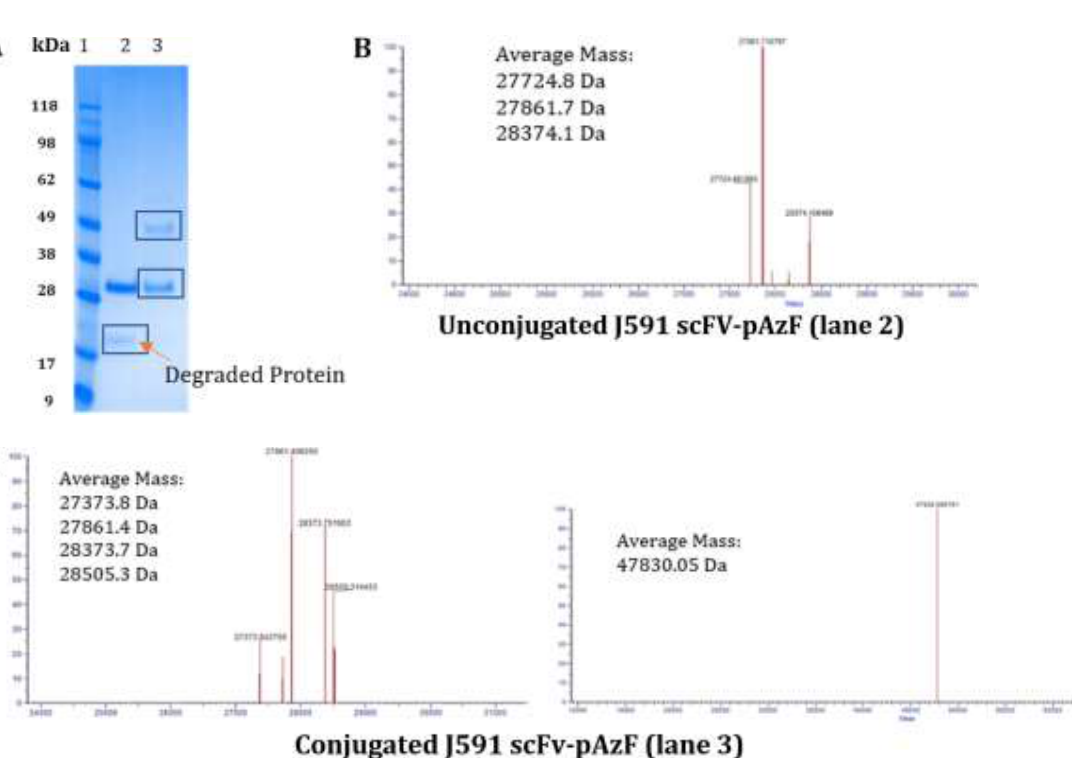
Figure 6. Verification of conjugation of DBCO-PEG4-DBCO with J591 scFv-pAzF. A) SDS PAGE show the unconjugated and conjugated scFvs. Lane 1: Marker; lane 2: unconjugated scFv; lane 3: conjugated scFv shows several bands containing excess scFv (unconjugated) and scFv-linker conjugates. B) Deconvoluted masses for unconjugated scFv as reported by Protein Deconvolution software. C) Deconvoluted masses for conjugated of scFv-DPD as reported by Protein Deconvolution software, measuring two MW species including excess scFv (unconjugated), and a higher MW species of ~47